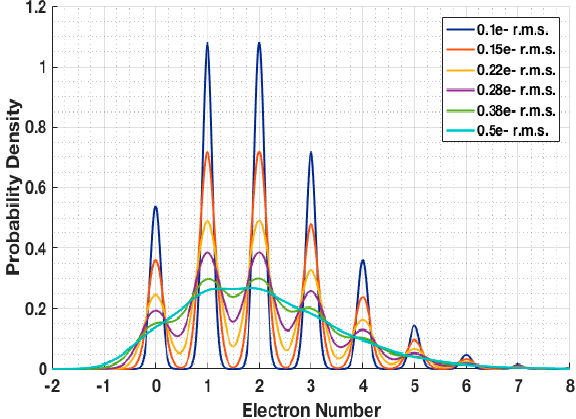
Figure 7. Readout signal probability density as a function readout signal for a quanta exposure H = 2 and for various read noise levels. Examples with CG variation are shown in [21,22].